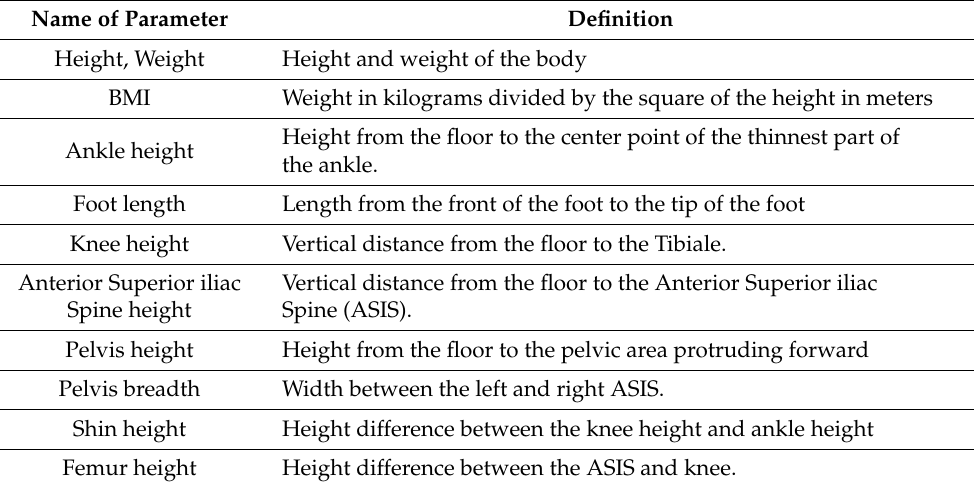
Table 5. Human body dimension